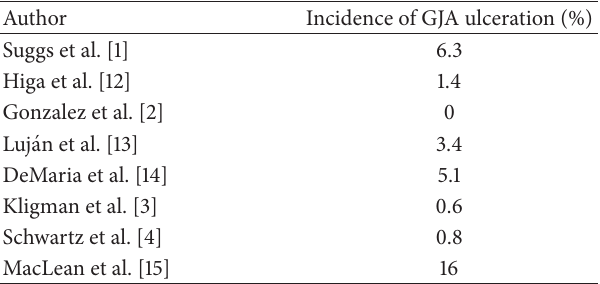
Table 1: Reported incidence of marginal ulceration of GJA after gastric